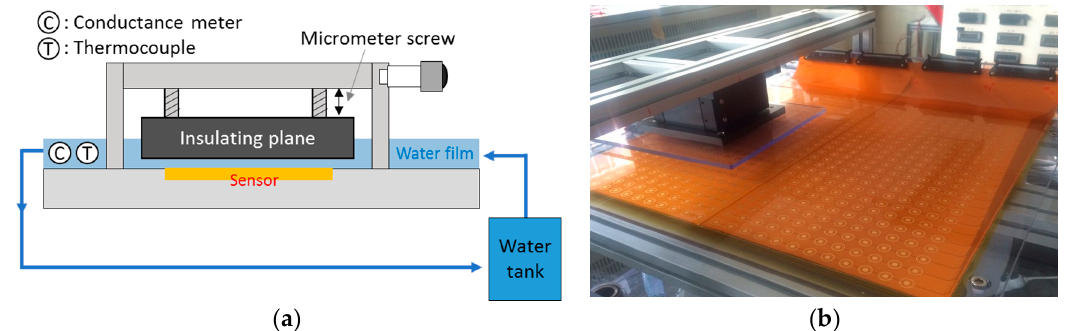
Figure 11. ( a ) Schematic diagram; ( b ) setup of the calibration device.